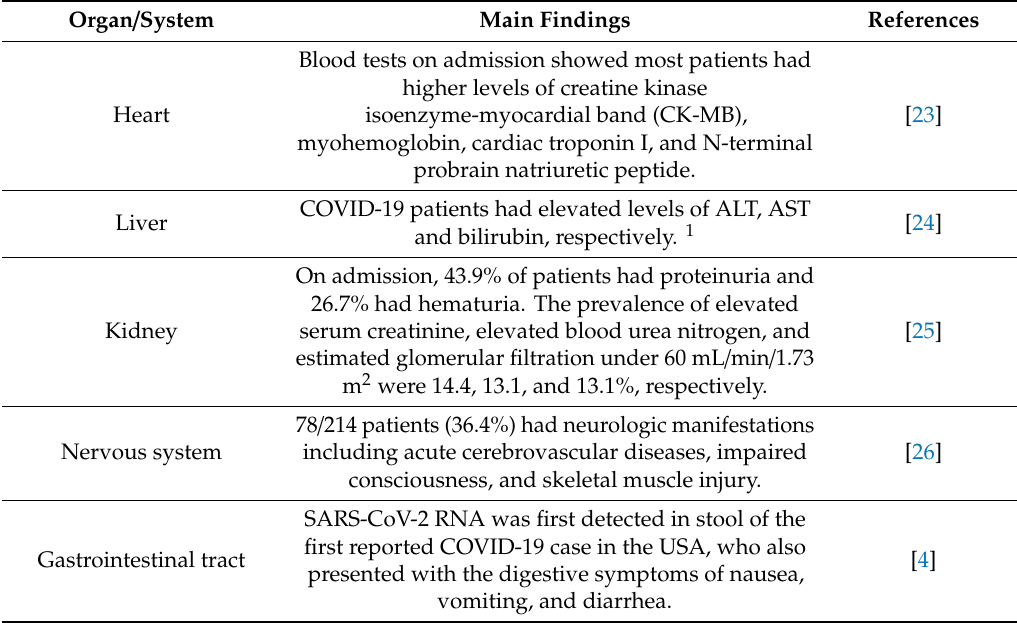
Table 2. Clinical and laboratory evidence of damage to extrapulmonary organs during SARS- CoV-2